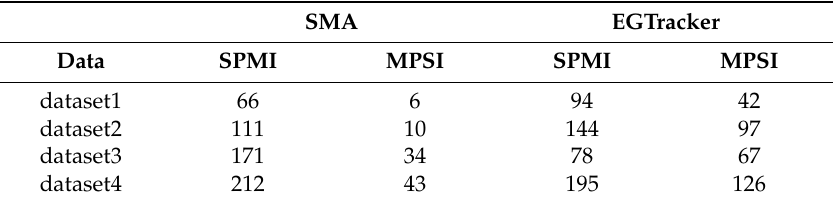
Table 2. The statistical result of spmi and mpsi.